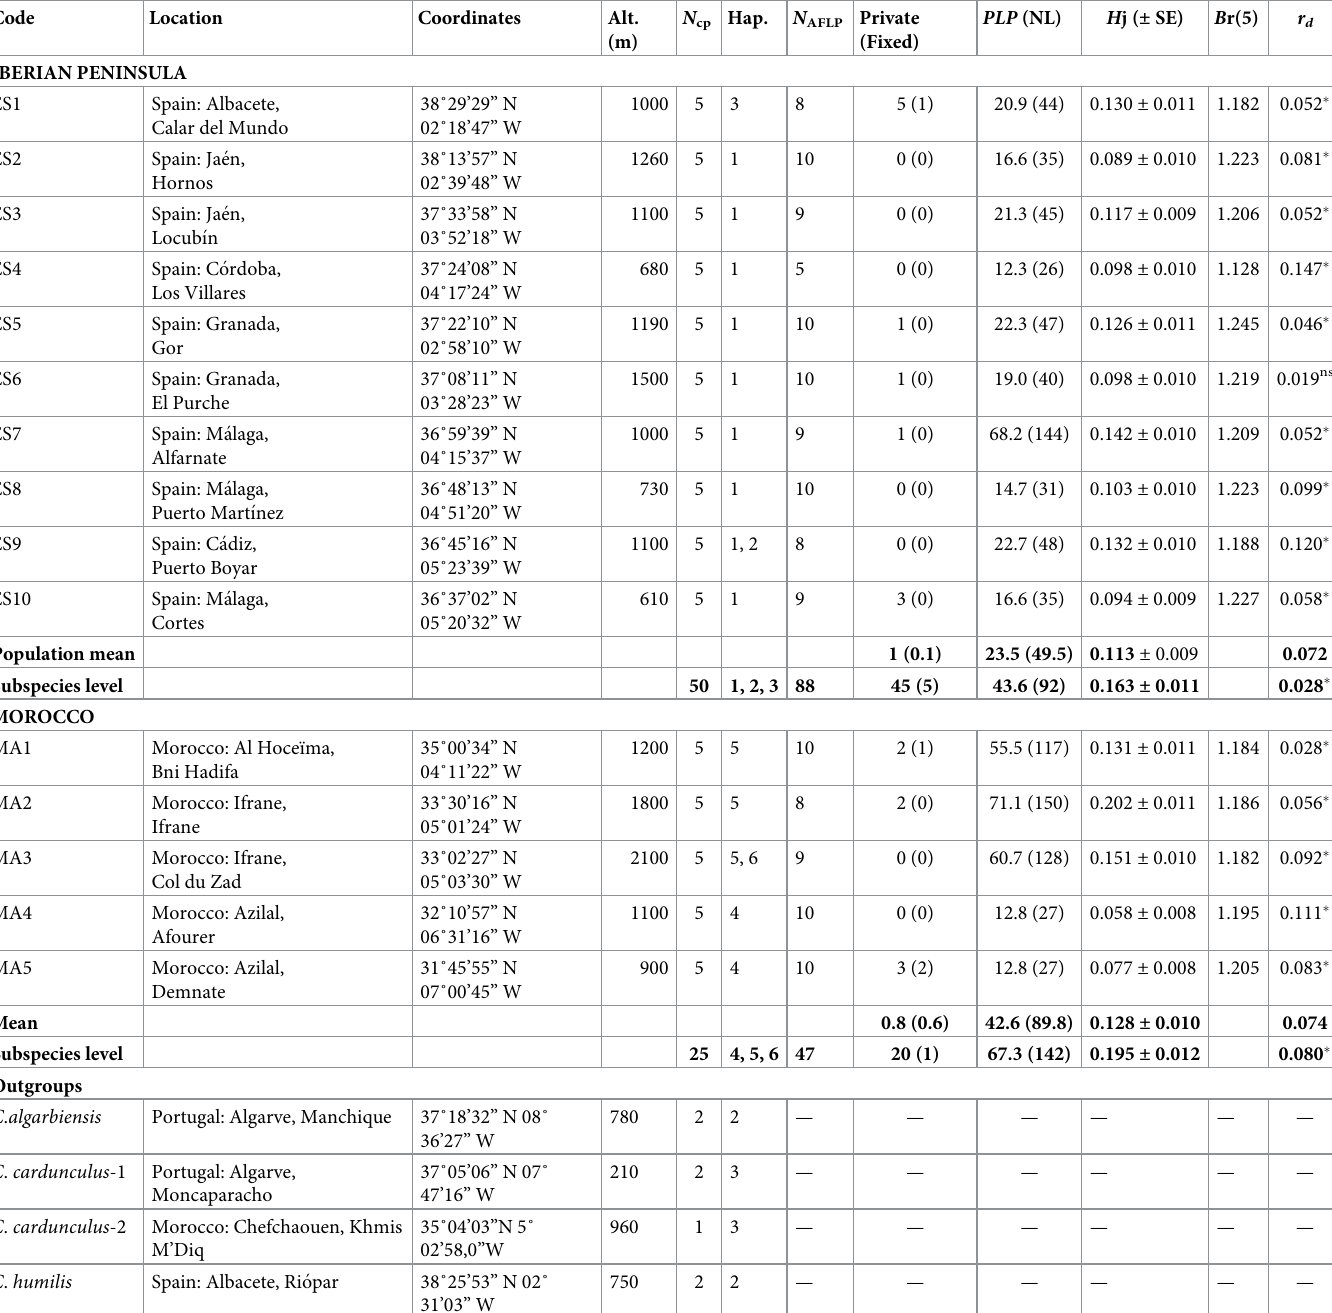
Table 2. Population dataset used in this study. Code of Cynara baetica populations or outgroup species, locations, coordinates, altitude (Alt.), number of samples used in plastid DNA study ( N cp ), number of haplotypes detected (Hap.), number of samples used in AFLP study ( N AFLP ), number of private (Private) and fixed (Fixed; in paren- theses) markers, percentage of polymorphic loci ( PLP ) and number of polymorphic loci (NL), average gene diversity ( H j), band richness after rarefaction ( B r 5 ), and index of association modified to remove the dependency of sample size ( r d ) ( � = p < 0.001; ns = not significant).